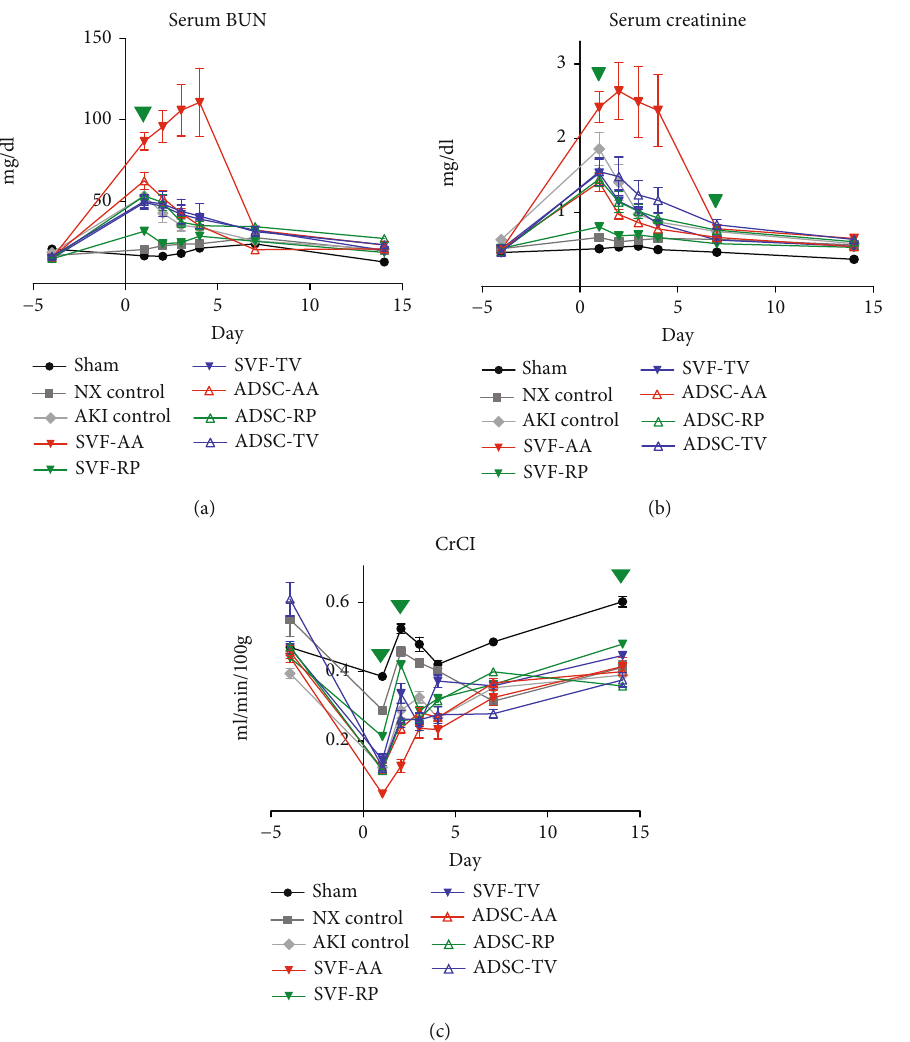
Figure 2: E ff ects of SVF and ADSC on renal function. Graphs showing changes in (a) serum BUN, (b) serum creatinine, and (c) CrCl of each group during the experiment. Green- and blue-colored inverted triangles indicate statistically signi fi cant di ff erences in the SVF-RP and SVF-TV groups compared to the AKI control group, respectively. 3 times per rat; 10 rats per group, but only until the time of survival of rats in the SVF-AA and ADSC-AA